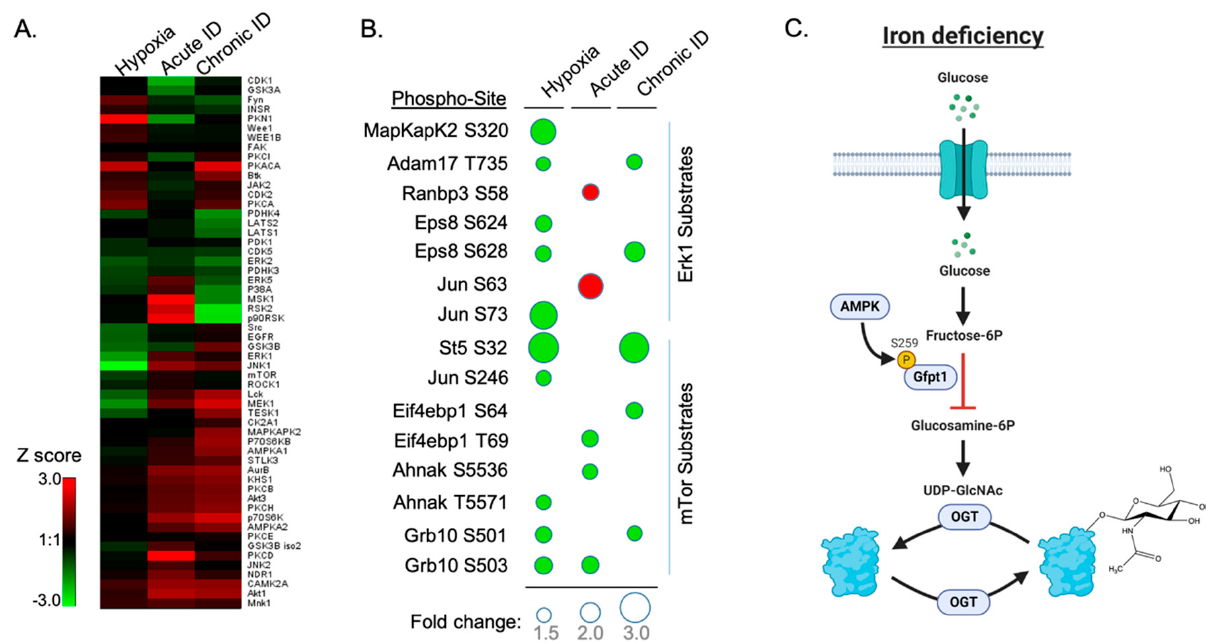
Figure 5. Kinase activity enrichment and clustering analysis of the phospho-proteome dataset. ( A ) Clustering of the Kinase Activity Score of each kinase comparing the kinase activation profile among all three treatments. ( B ) Bubble heat map showing Extracellular Signal-regulated kinase 1 (Erk1) and mTOR phospho-sites were significantly changed under all treatments. Bubble size indicates level of fold change in phosphorylation site with SILAC ratio < 0.66 (Green) and >1.5 (Red). ( C ) Scheme illustrating ID-induced phosphorylation of GFPT1 S259 and thereby reducing the synthesis of glucosamine-6P in the O-GlcNAc pathway.